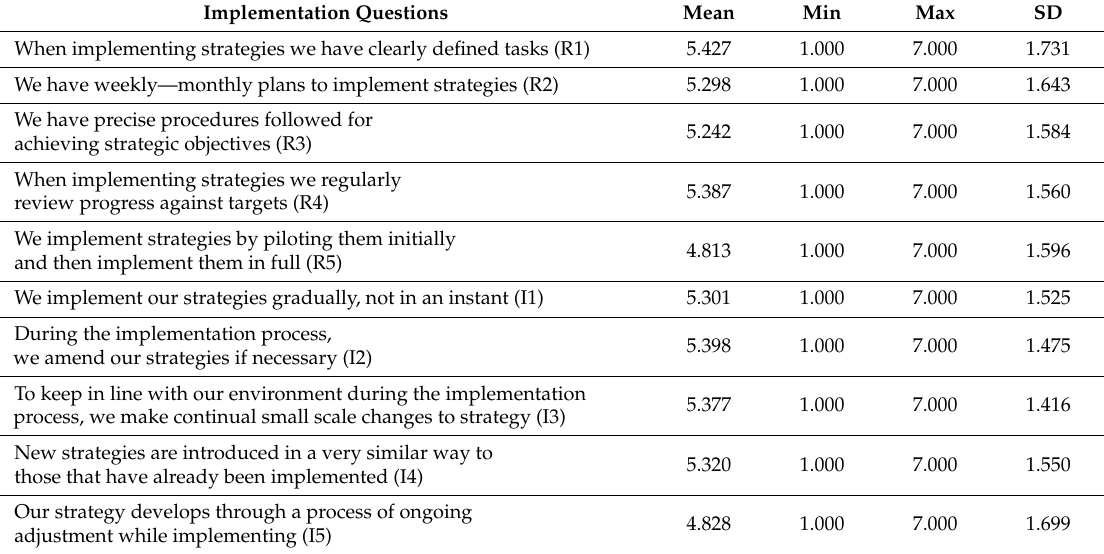
Table 1. Strategy implementation style